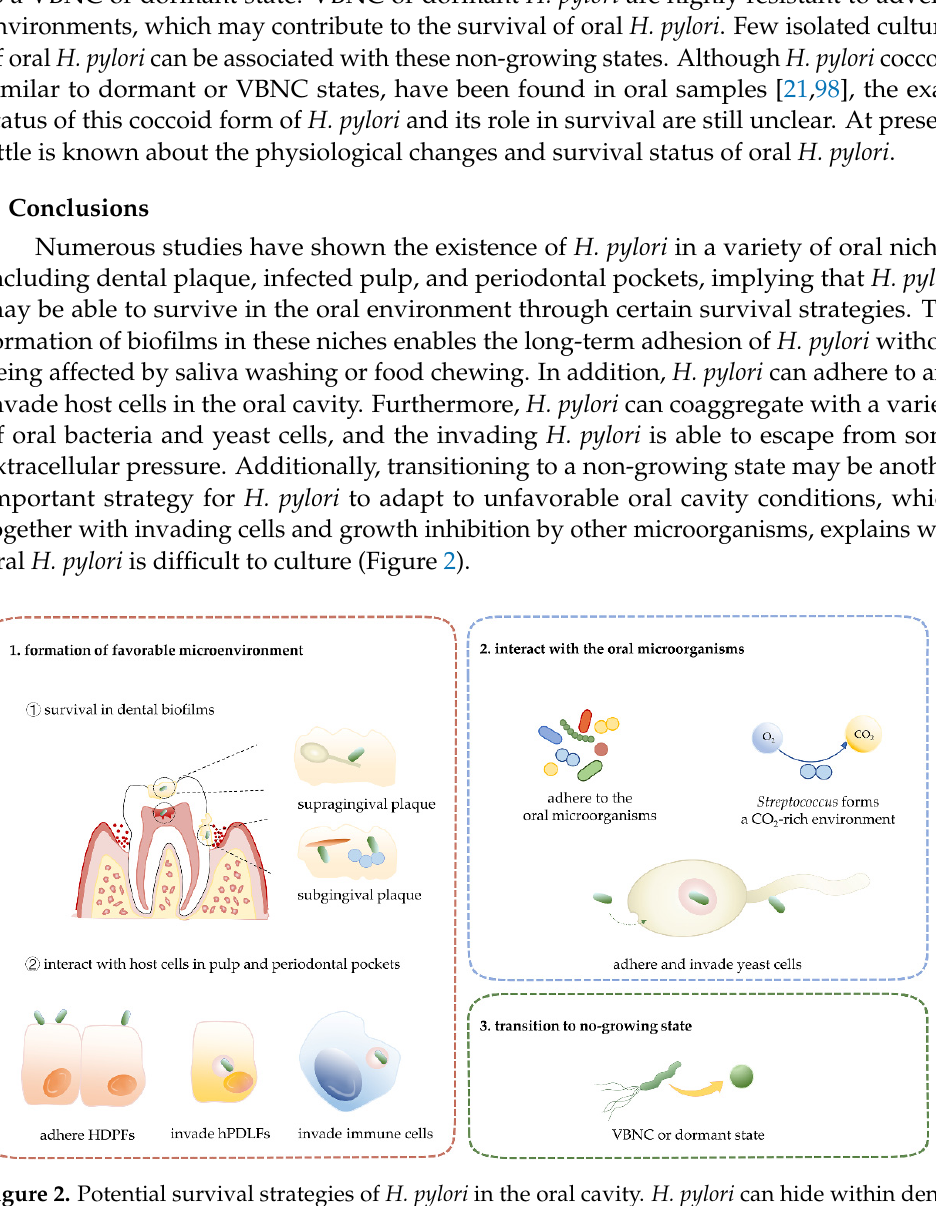
Figure 2. Potential survival strategies of H. pylori in the oral cavity. H. pylori can hide within dental plaque biofilm in caries cavities and periodontal pockets. Moreover, this organism has the ability to adhere to and invade host oral cells in these niches. Synergistic interaction with oral microorganisms and transition to a VBNC or dormant state may also help H. pylori adapt to adverse conditions in the oral cavity.